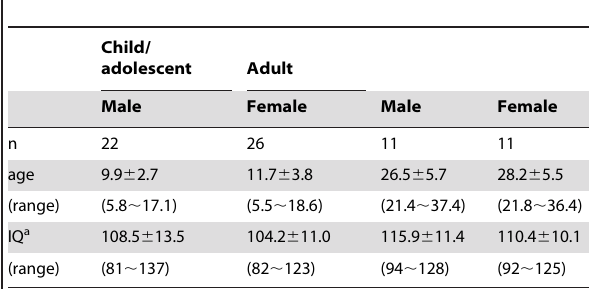
Table 1. Mean of age and IQ in each